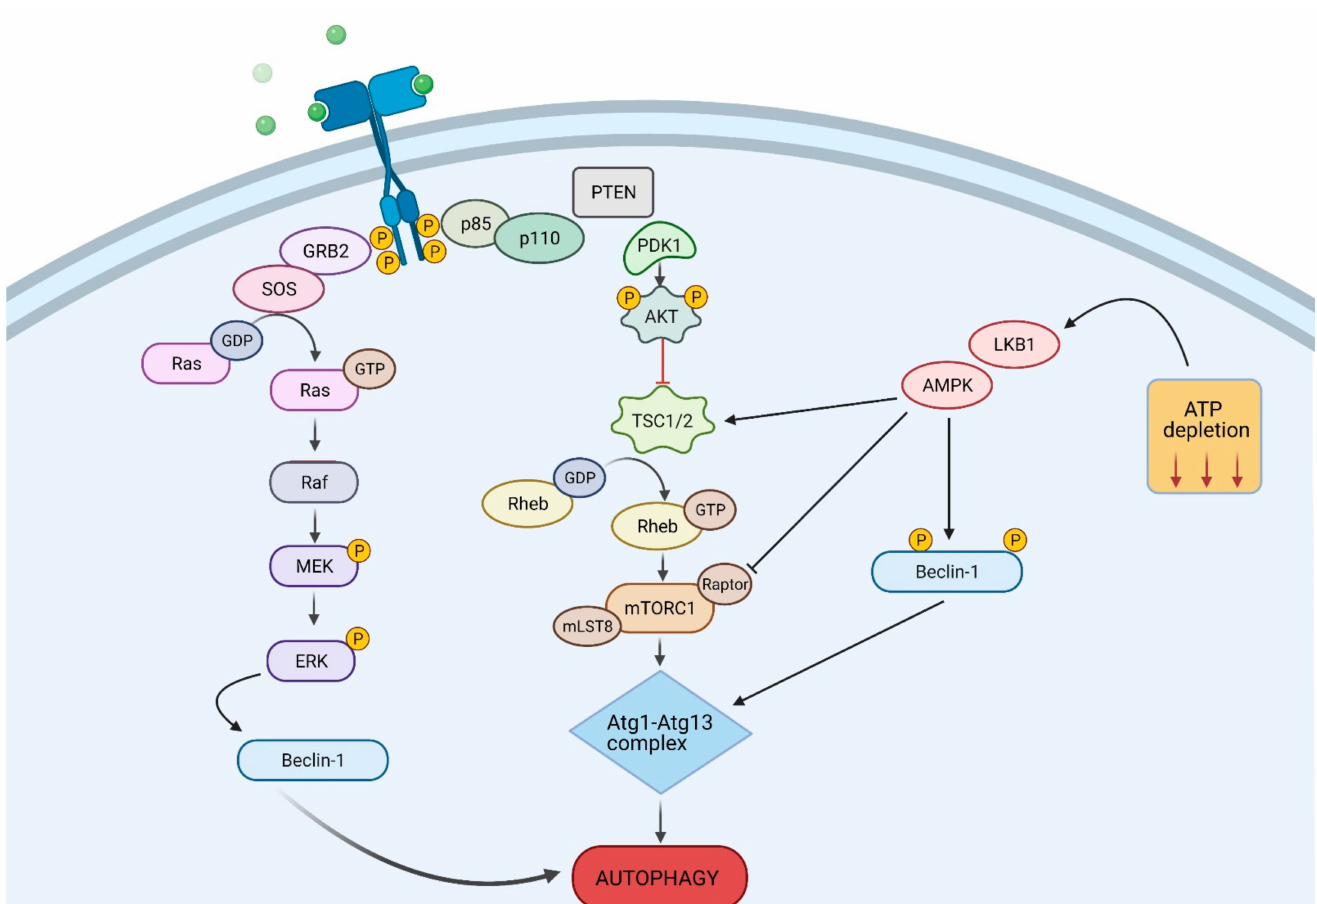
Figure 2. Autophagy Signalling Pathways. Multiple signalling pathways, some of which are shown in the figure, regulate autophagy. The main players are the mTOR kinase, that activated by growth signals suppresses autophagy, and Beclin-1, that activated by stress signals induces the formation of the phagophore membrane. GRB2, Growth factor receptor-bound protein 2; SOS, Son of sevenless; p85, Phosphoinositide-3-Kinase Regulatory Subunit; p110, Phosphoinositide-3-Kinase catalytic Subunit; PDK1, Phosphoinoisitide-dependent kinase-1; PTEN, Phosphoinoisitide dependent kinase; TSC1/2, Tuberous sclerosis proteins 1 and 2; RHEB, Ras homolog enriched in brain; Raptor, Regulatory-associated protein of mTOR; mLST8, mammalian lethal with SEC13 protein 8; LKB1, liver kinase B1; Raf, Rapidly Accelerated Fibrosarcoma; MEK, Mitogen-activated protein kinase kinase; ERK, extracellular signal-regulated